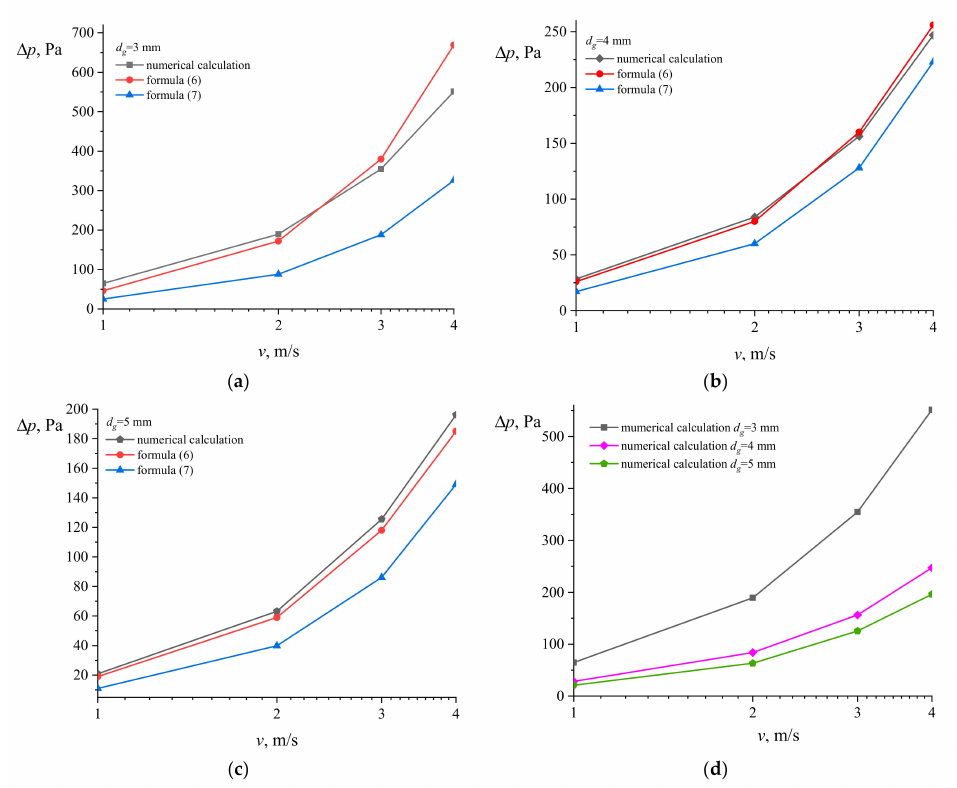
Figure 3. Dependence of the pressure drop on the gas flow rate: ( a ) d g = 3 mm; ( b ) d g = 4 mm; ( c ) d g = 5 mm; ( d ) comparison of the numerical simulation